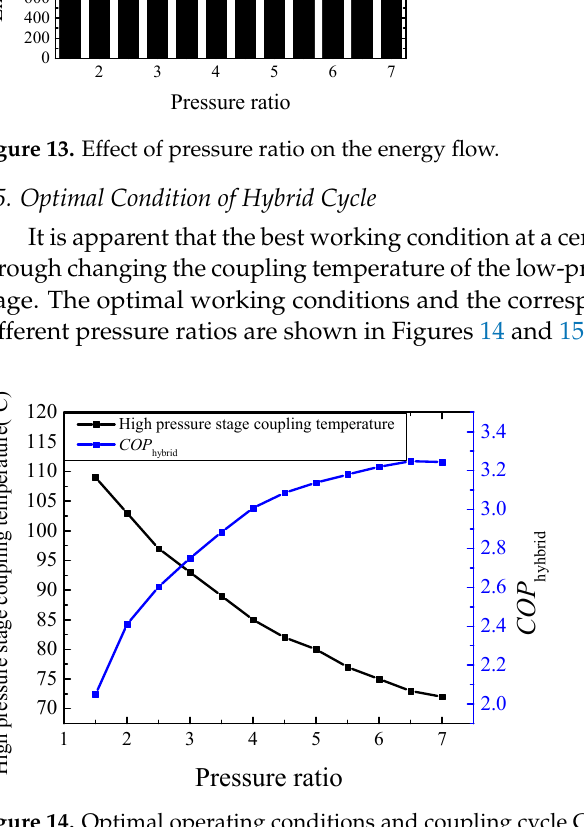
Figure 14. Optimal operating conditions and coupling cycle COP under different pressure ratios.